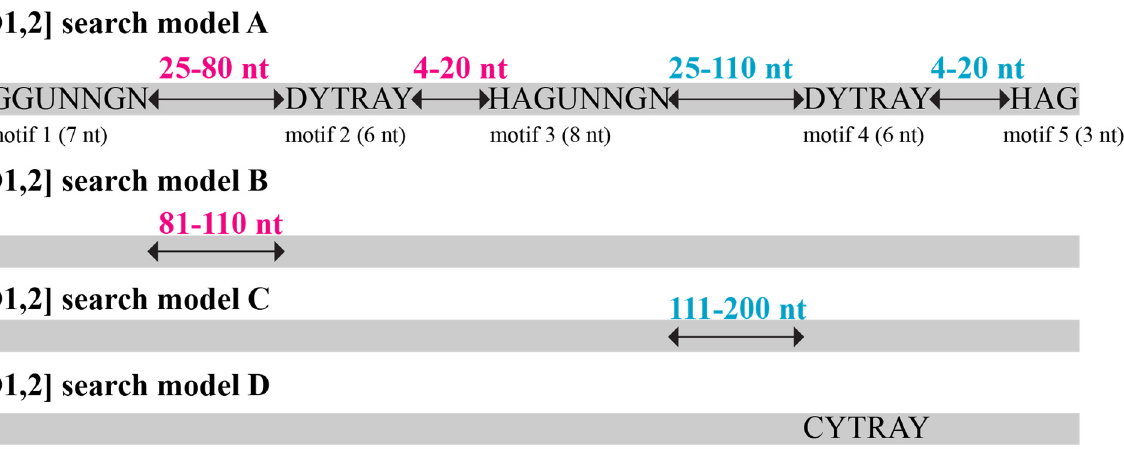
Figure 2. Graphic scheme of the stwintron search models employed to identify candidate [D1,2] stwintrons occurring in DNA contigs. Five degenerated sequence motifs (5 ′ to 3 ′ numbered as motifs 1–5) consisted of the consensus 5 ′ -donor, BP element and 3 ′ -acceptor sequences from the constituent U2 introns and comprised two hybrid motifs that included nts from both internal and external introns (motifs 1 and 3, respectively). These hybrid motifs were specific to the type of stwintron (i.e., [D1,2], [D2,3], [D3,4], [D4,5] or [D5,6] for [D] class stwintrons). The distance ranges between consecutively degenerated sequence motifs are defined as detailed in Sections 2 and 3. The set distance ranges within the internal intron are printed in red lettering and those within the external intron in blue lettering. The initial search was carried out with [D1,2] Search Model A, which identified 90 Hypoxylon sp. CO27-5 [D1,2] stwintrons. Below the graphic scheme of Search Model A, abbreviated schemes for three further search models ([D1,2] Search Models B, C and D, respectively) show only the variables that were changed. These three secondary screens identified 22 additional [D1,2] stwintrons missed by Search Model A.